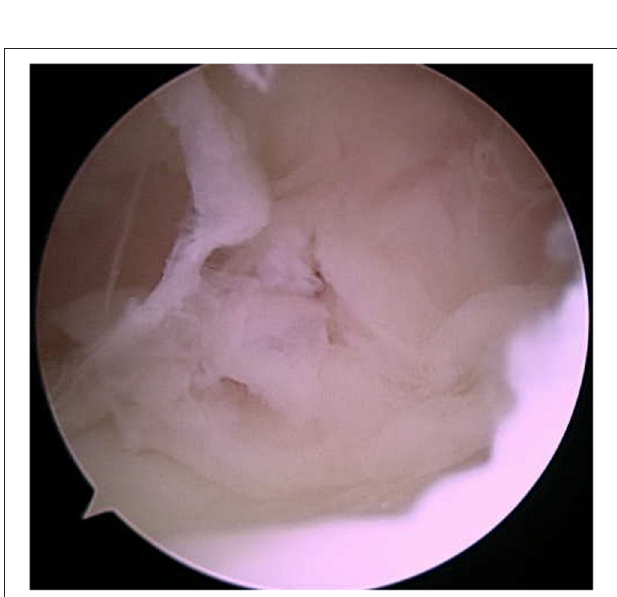
of nuchal bursitis ( Figure 3 ). Copious lavage and